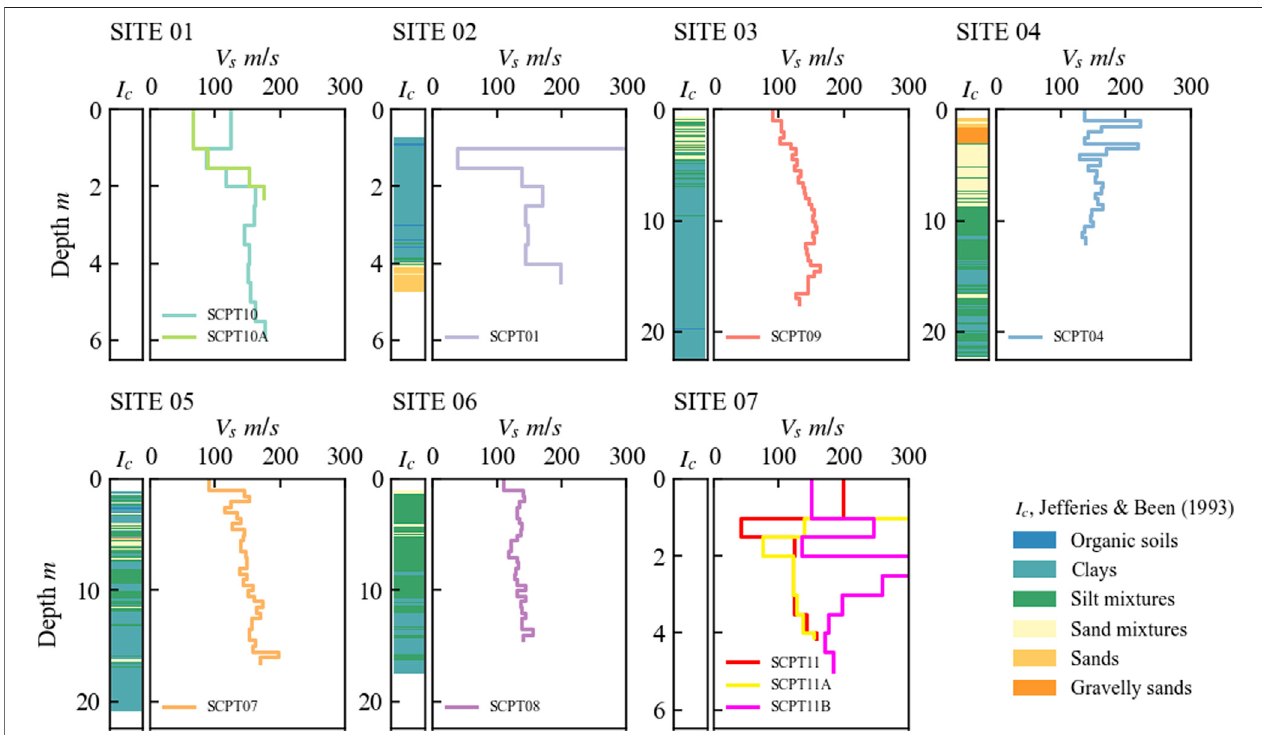
FIGURE 6 | Shear-wave velocity results at the seven sites. Where a CPT result is available, the soil pro fi le is represented as the I c designation (Been and Jefferies, 1993).